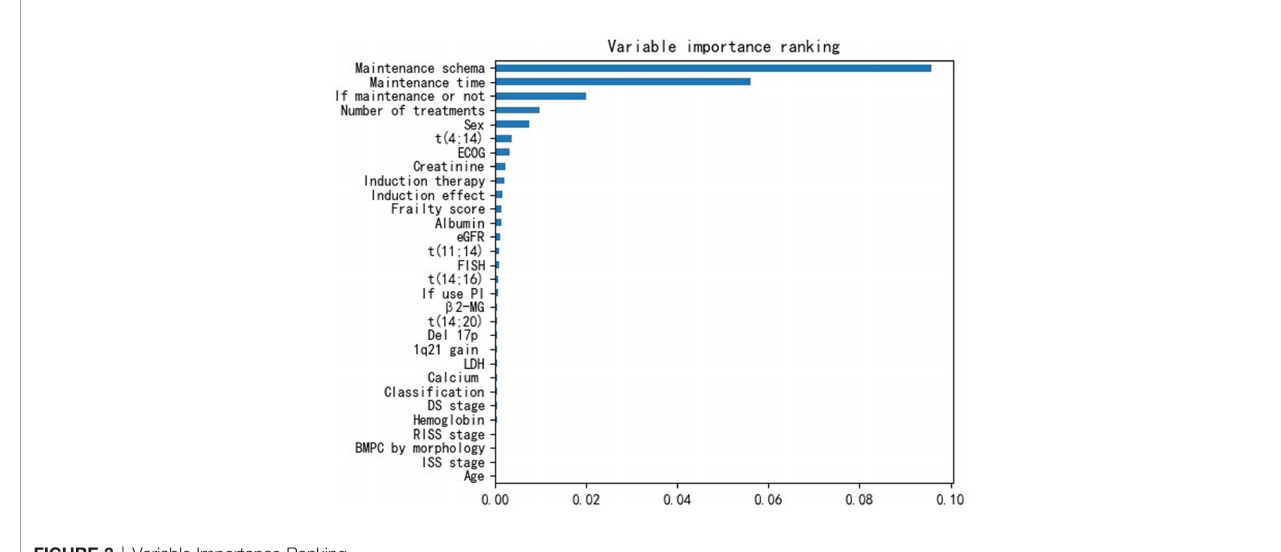
FIGURE 3 | Variable Importance